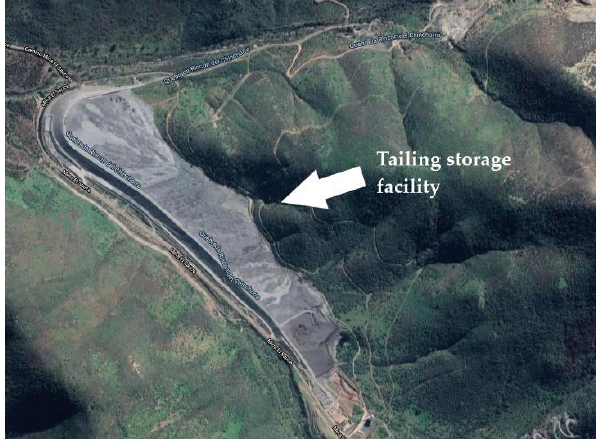
Figure 1. Tailing storage facility (32 ◦ 28 (cid:48) 16.1” S, 71 ◦ 05 (cid:48) 00.2” W).